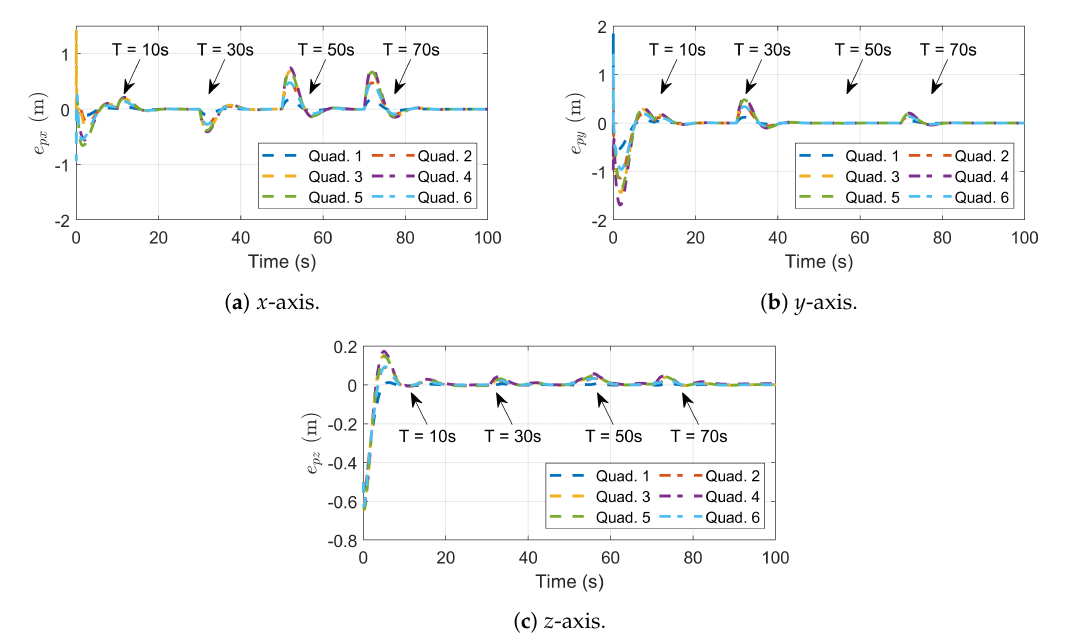
Figure 8. Multi-line formation flight tracking error of the six quadcopters along the x -, y -, and z